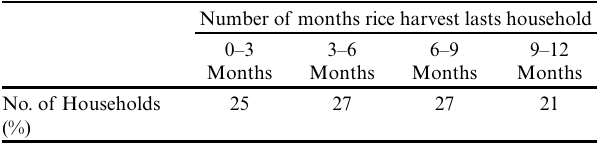
Table 2 . The number of months that harvested rice from a household’s fields met household consumption needs. (Each cell represented as a percentage of all households [N = 298; there were two no-responses for this question]).